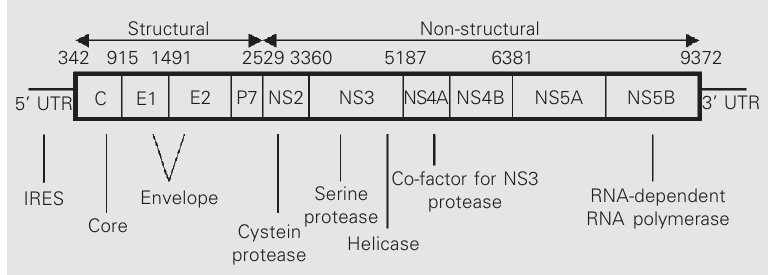
Figure 1. The genomic organization of hepatitis C virus. The two ends contain untranslated regions (UTR), which are shown as lines (5' UTR and 3' UTR). Downstream from the 5' UTR there is an open reading frame encoding a single large polyprotein that is processed into structural and non-structural (NS) proteins by viral and host enzymes. Nucleotide positions are reported according to the HCV J4 strain (GenBank accession number D10749). IRES = interferon sensitivity